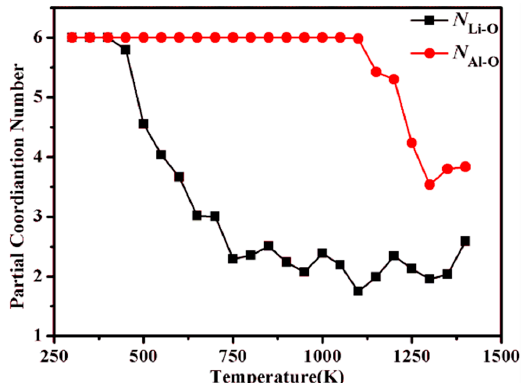
Figure 4. Evolution of the partial coordination numbers of Li and Al by O atoms with temperature in LiAl 2 (OH) 6 Cl.